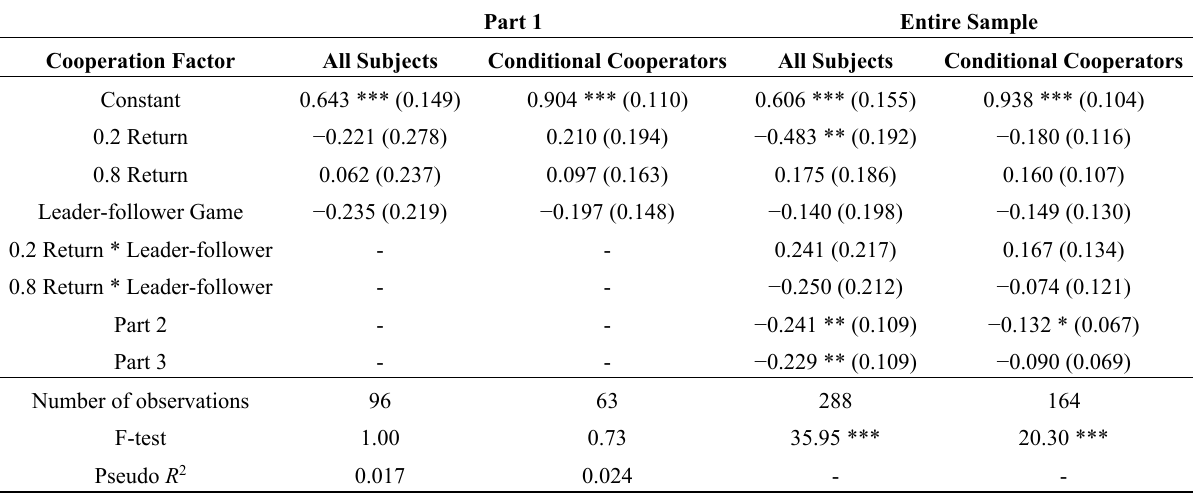
Table 5. The results of Tobit regressions with cooperation factor as the dependent